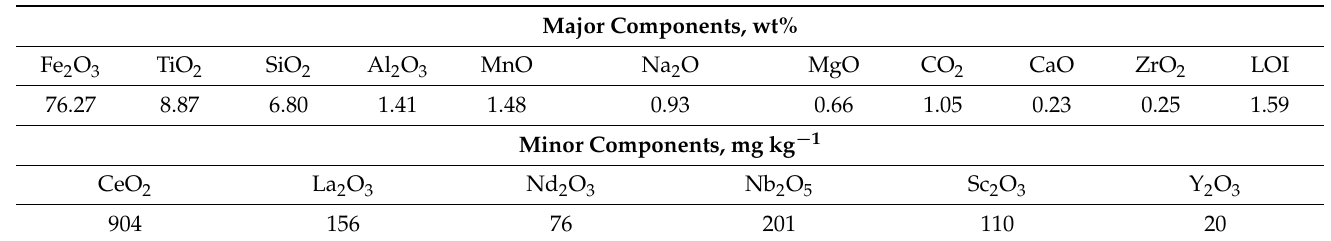
Figure 9. The mechanism of selective Sc leaching from RMF. Table 3. Chemical composition of the red mud after selective REE leaching at pH 2, T = 70 °C, L:S = 10 and τ = 30 min.